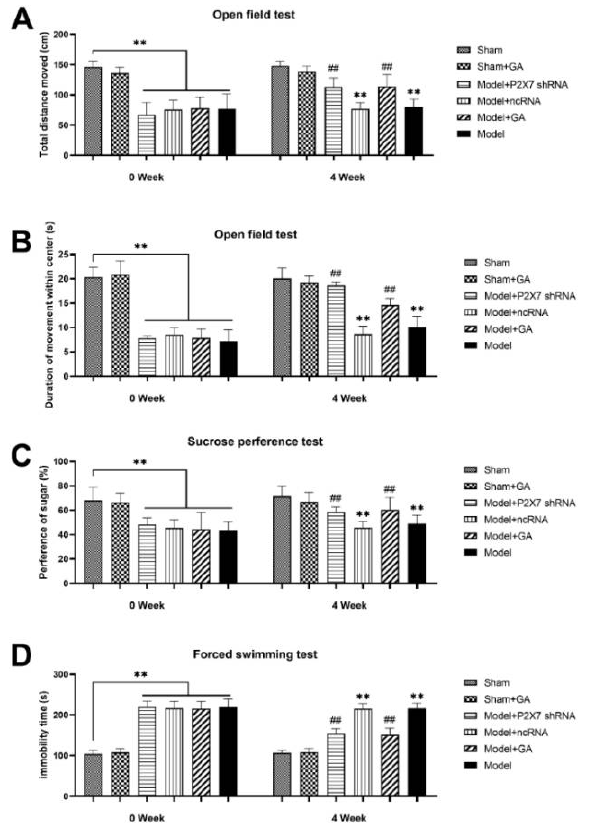
Figure 3. The depression levels of rats were reflected in the results of three independent behavioral tests (OFT, SCPT, and FST). Total moving distance ( A ) (F(5,53) = 42.329, p < 0.001) and duration of movement ( B ) (F(5,53) = 83.529, p < 0.001) within the center of the field before (0 week, 56 days age) and after (4 week) treatment in the OFT (5 min); preference of sugar ( C ) (F(5,53) = 15.273, p < 0.001) before and after treatment in the SCPT; IT ( D ) (F(5,53) = 140.105, p < 0.001) before and after treatment in the FST (5 min). The data in the first six columns of all bar charts are the data from before the treatment, and the data in the last six columns are the data from after the treatment. Every histogram bar includes the values from more than nine different samples. Values are means ± SEM. ** p < 0.01 vs. sham group; ## p < 0.01 vs. model